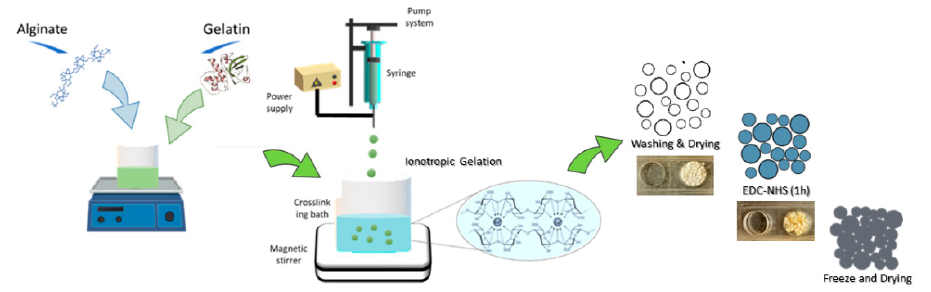
Figure 1. Schematic representation of the preparation 3D scaffolds via EFDA/freeze drying.